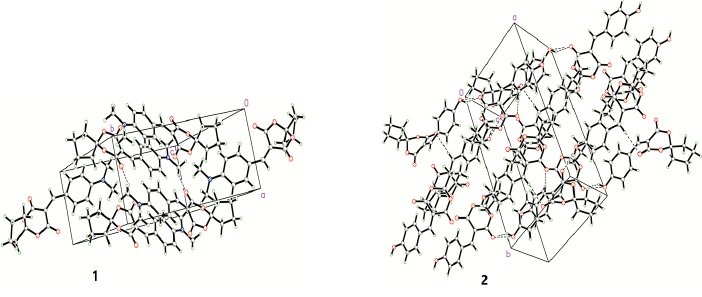
Figure 2. The packing arrangement in a unit cell of 1 and 2. Table 2. Intra- and intermolecular hydrogen bonds and C–H··· π supramolecular interactions in 1 and 2 .